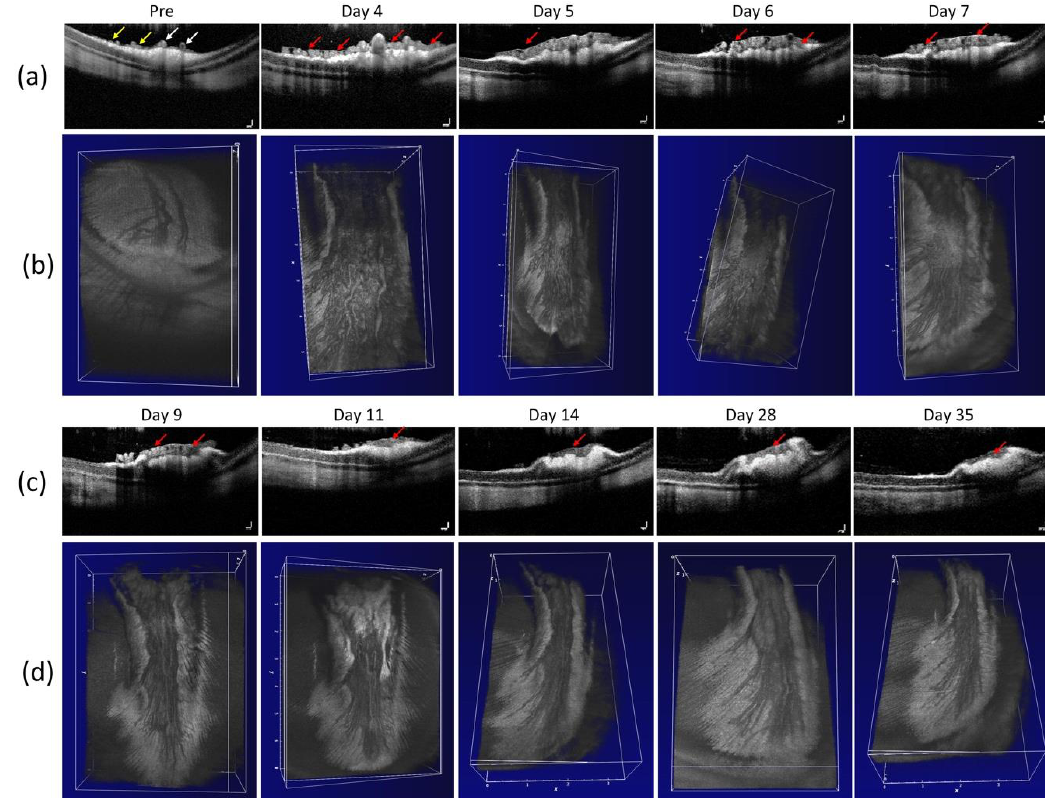
Figure 3. In vivo evaluation of a retinal neovascularization. ( a , c ) Cross-sectional B-scan OCT images acquired along the scanning lines from Figure A1. The OCT image showing choroidal vessels (CVs), retinal vessels (RVs), retinal neovascularizarion (RNV) and retinal layers. Yellow arrows show the position of the existing retinal blood vessels. Red arrows depict the location of RNV. ( c , d ) 3D volumetric OCT images for the retinal neovascularization.